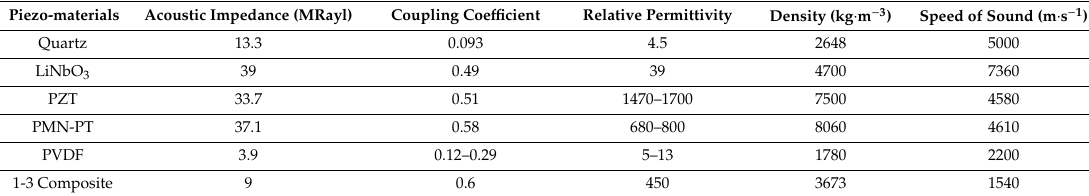
Table 1. Material properties of widely used piezoelectric materials in manufacturing of ultrasound transducers